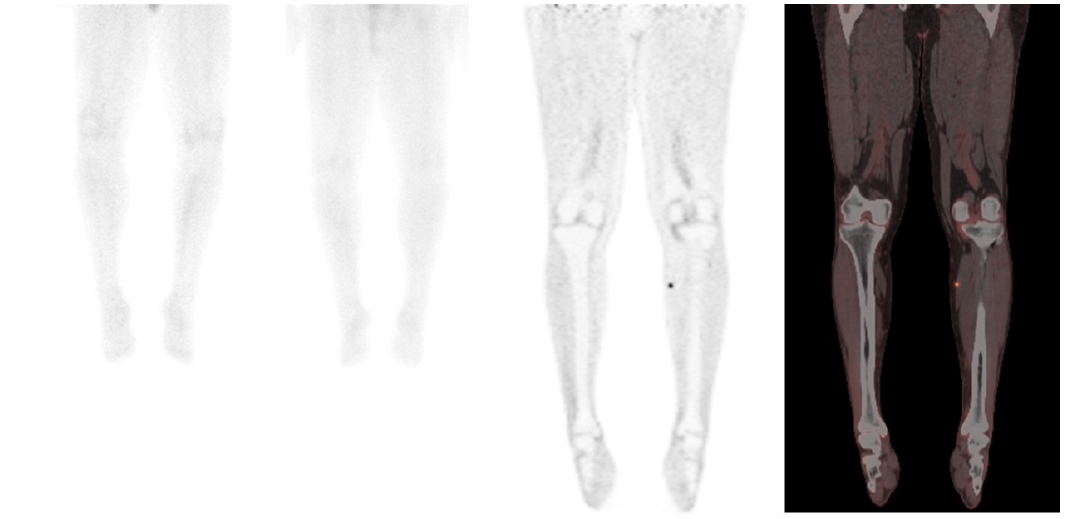
Figure 1. FDG PET/CT shows a focal milimetric focus not visualized on octreotide scan a day prior to PET/CT scan.